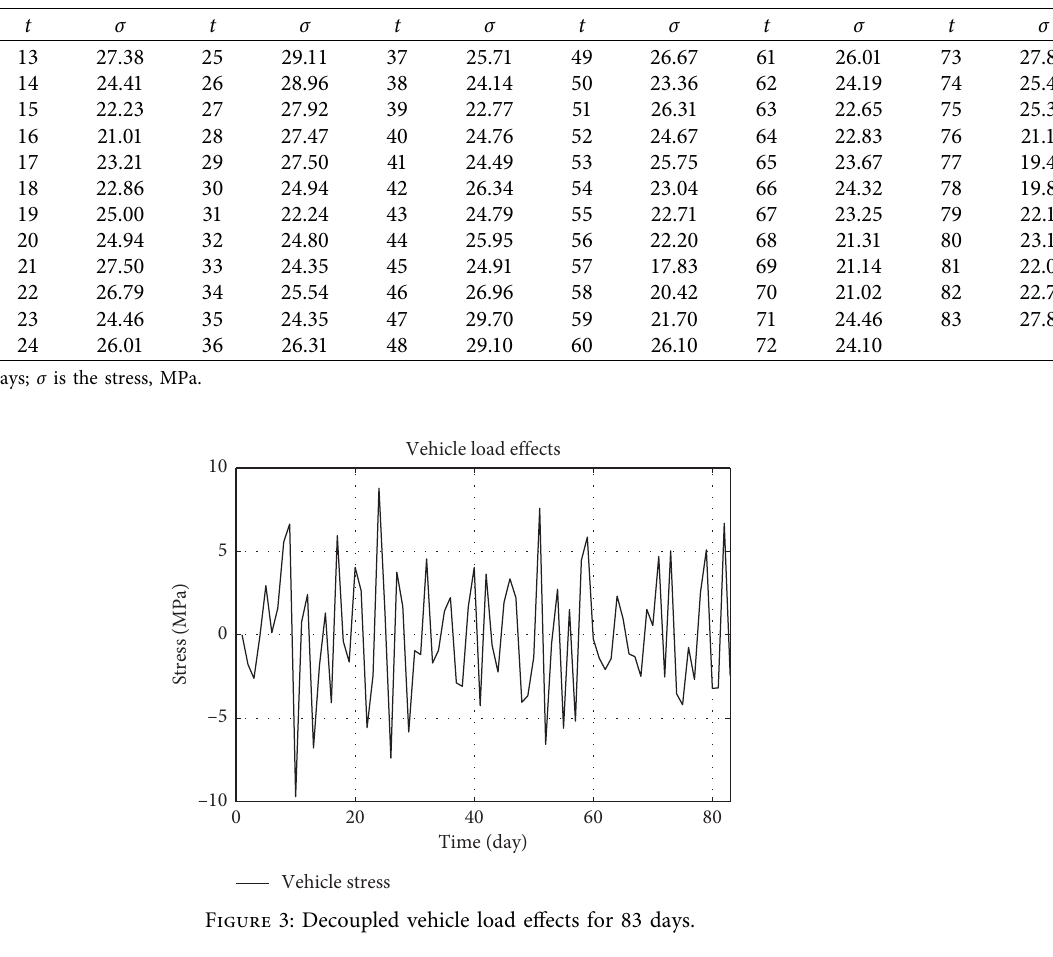
Table 2: Decoupling temperature load effects’ data for 83 days.